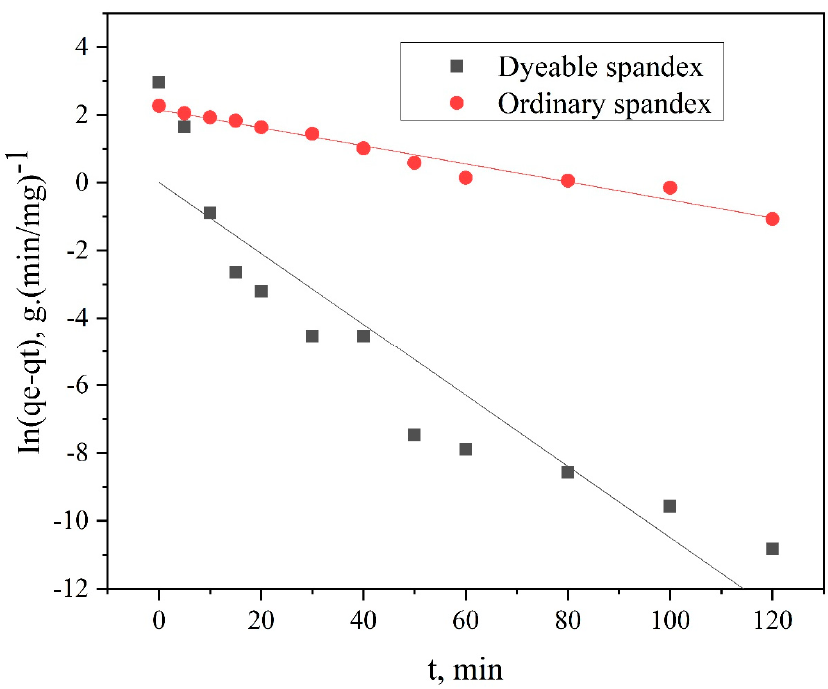
Figure 9. Pseudo–first-order kinetic model of neutral red G dyeing spandex.